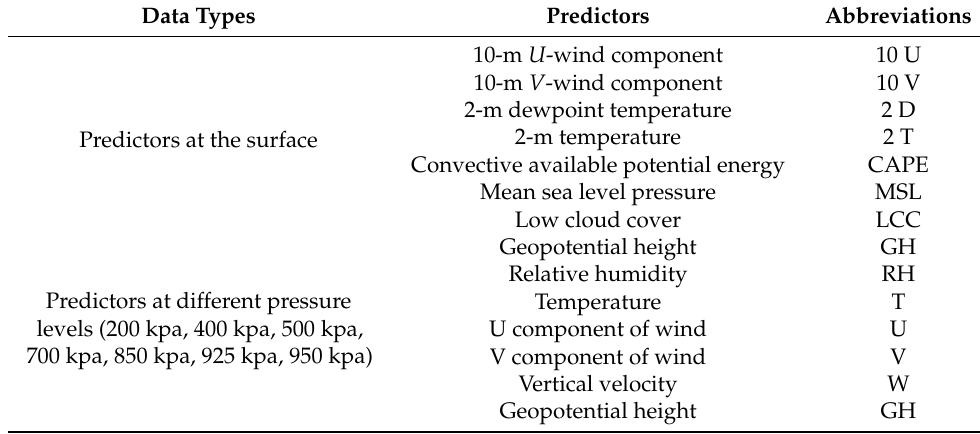
Table 1. The selected predictors and their abbreviations.